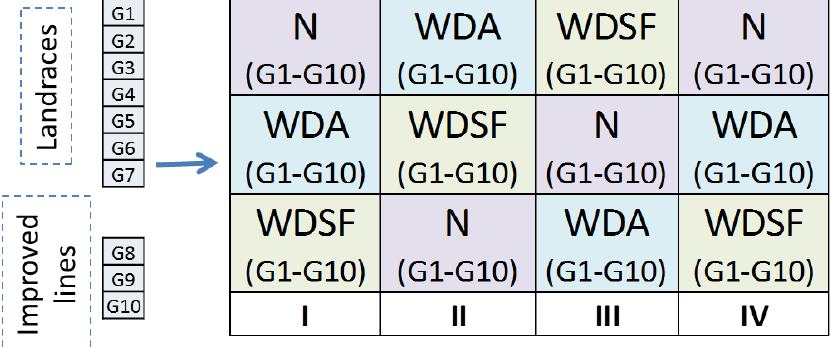
Figure 5. The split-plot design with 4 replications, the main plot with the irrigation treatments (N, WDA and WDSF) and the sub-plots with the 10 genotypes randomized within the main